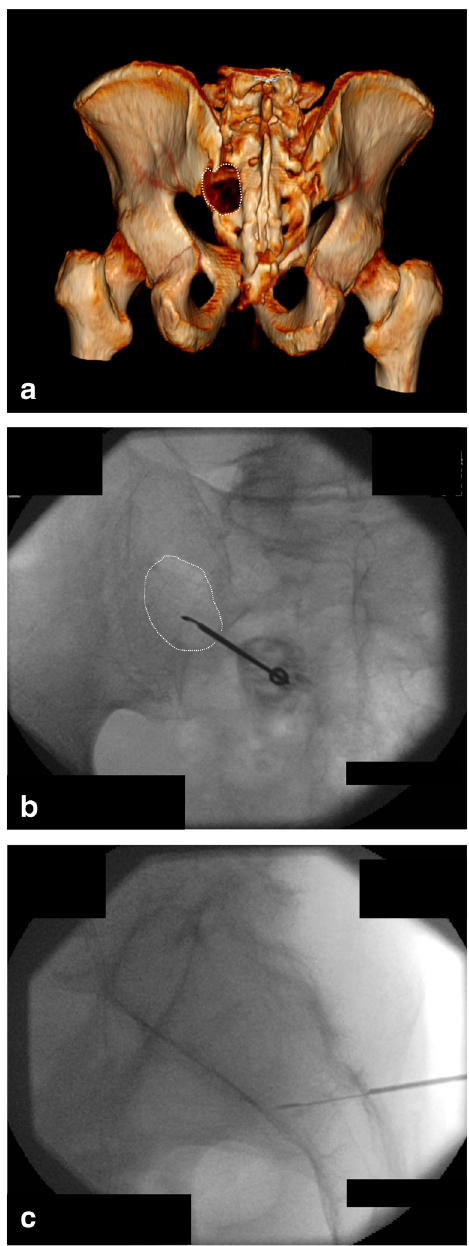
Fig. 1 A 77-year-old man with clinical background of melanoma pre- senting with a new lytic lesion in the left sacral wing. a CT 3D recon- struction shows the lytic lesion ( white dotted line ). b , c PA and lateral fluoroscopic views were used to guide the biopsy, which was performed with a coaxial 16-G cutting needle and confirmed melanoma